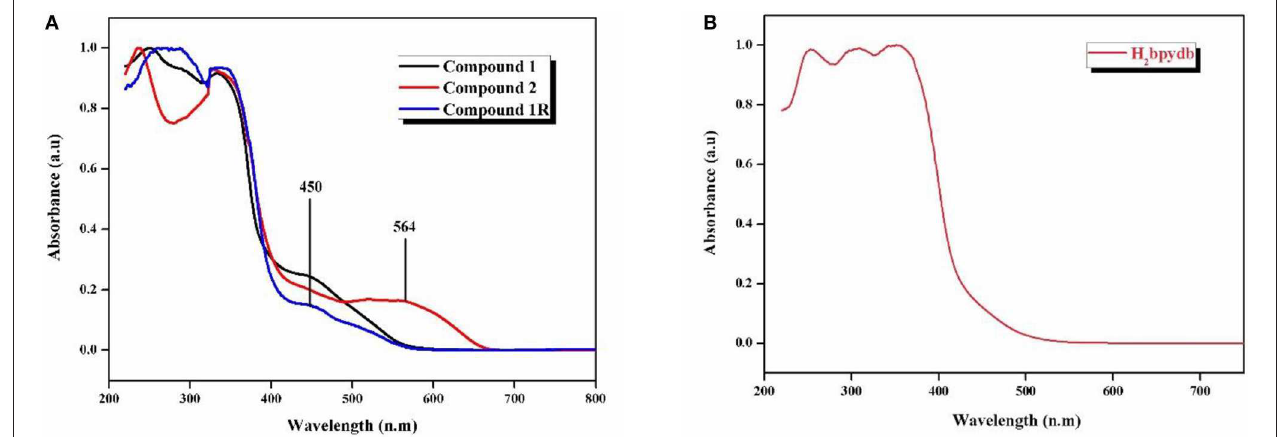
FIGURE 6 | Solid state-diffuse reflectance spectra (DRS) of (A) compounds 1 , 2 , and 1R and (B) H 2 bpydb